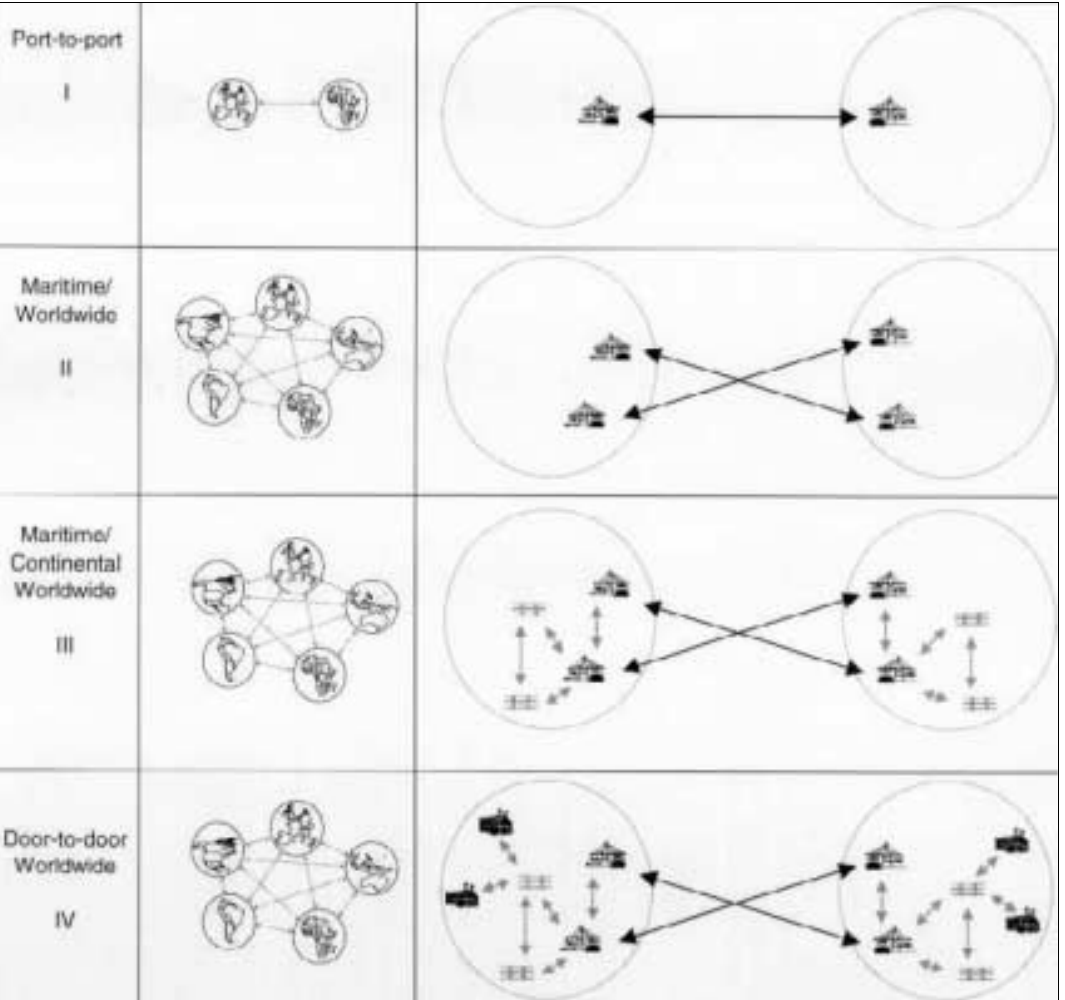
Figure 3. Logistic concepts for the application of foldable containers The above-mentioned concepts differ on some important aspects: ! Type of network : ranging from point-to-point relations (concept I) to a